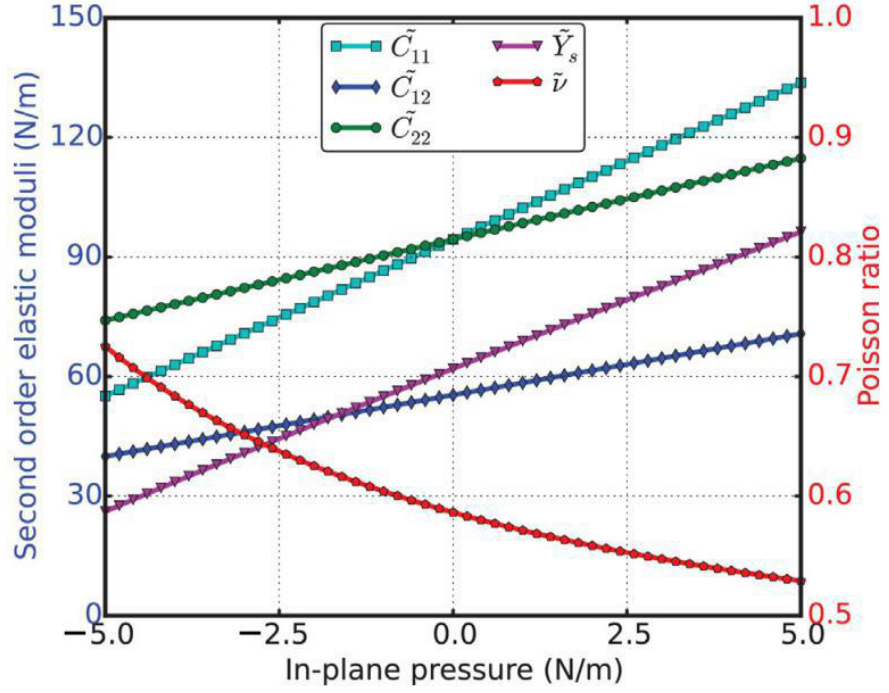
Figure 21. Pressure effect. Second-order elastic moduli, in-plane Young’s modulus, and Poisson’s ratio as a function of the pressure predicted from the high-order elastic constants .